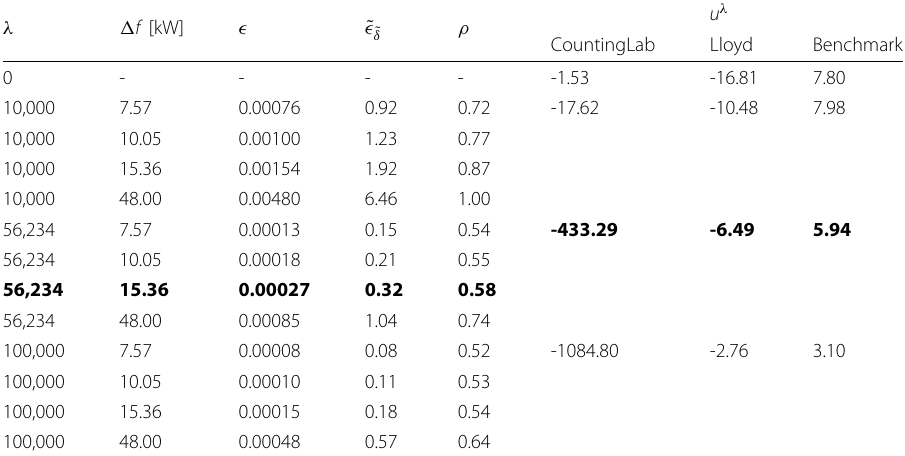
for k-fold adaptive composition ( k = 38,